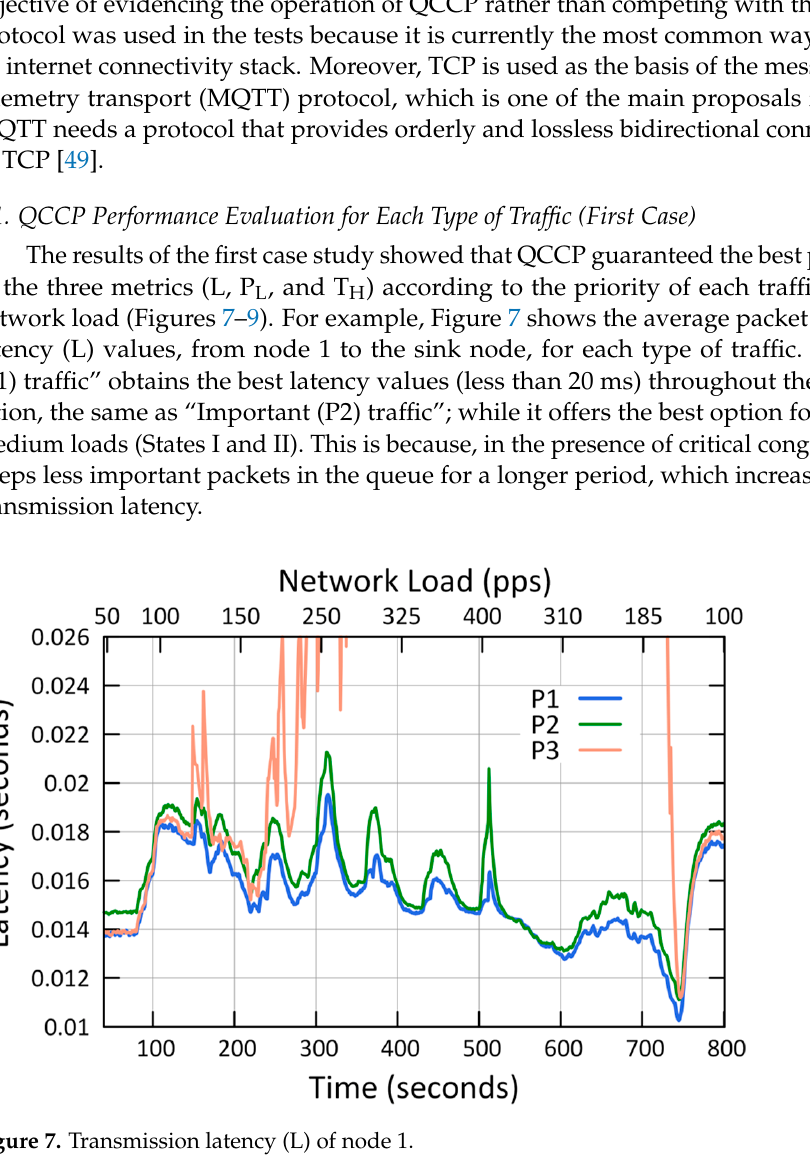
Figure 8. Packet loss (P L ) in the network. Figure 9. Throughput (T H ) in the Network. As a result of this queuing, as the buffer reaches its storage limit, the packets are dropped to control network congestion. In this regard, Figure 8 shows the number of packets lost (both due to buffer overflow and channel saturation) in the network for each type of traffic. For example, in the same figure, when the network is at maximum conges- tion (400 pps—axis X2), the network loses 81.1% for P3 traffic, 33.5% for P2 traffic, and